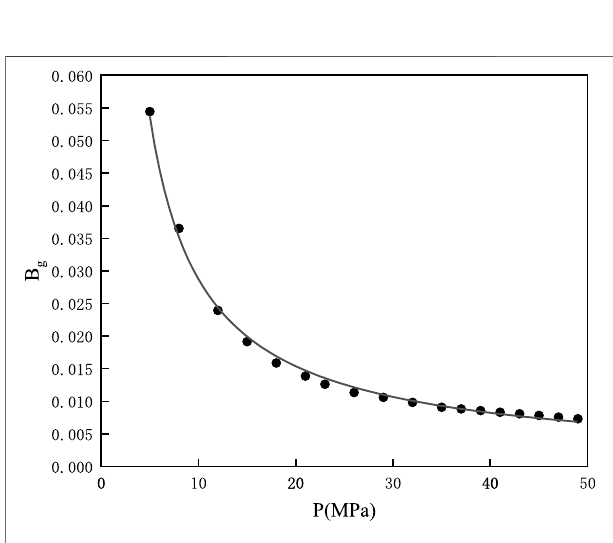
FIGURE 2| Curve of the gasvolume factor versus formation pressure of shale gas Block